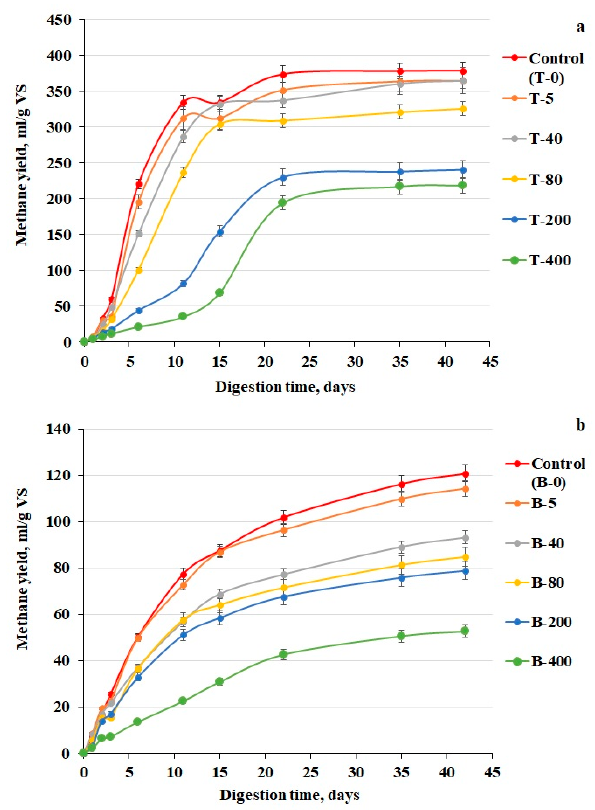
Figure 1. Dynamics of methane accumulation (ml/g volatile solids (VS) initial) in experiments on the determination of polyacrylamide (PAM) toxicity ( a ) and PAM biodegradability ( b ). Specific methane yield was calculated considering the organic matter of the PAM.